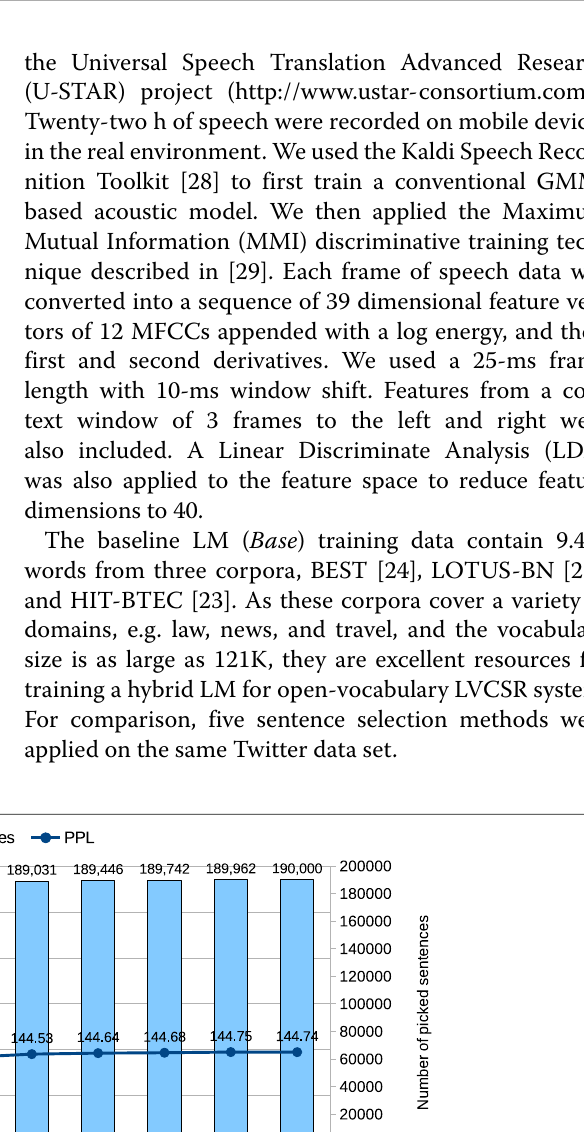
Fig. 3 Perplexities with accumulation of groups for SVM-based scoring